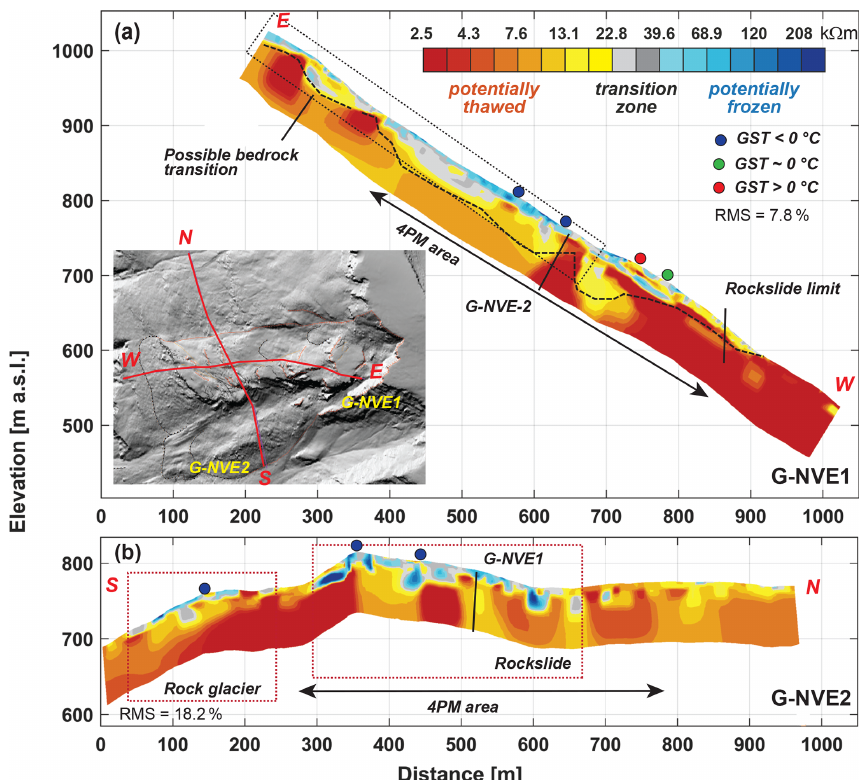
Figure 8. The long ERT profiles for Gámanjunni-3. The colour scale follows the laboratory analysis shown in Fig. 3 and is a logarithmic scale. (a) G-NVE1, showing high-resistivity layers down to ca. 700ma.s.l. (box). The dashed line indicates the possible transition to solid bedrock. (b) G-NVE2, the cross-profile over the rock glacier and the lower rockslide area, indicated by the red boxes. The circles in both profiles indicate the location and mean annual GST in the vicinity of the profiles based on Eriksen (2018) and subsequent measurements (Gudrun D. Majala, NVE, unpublished data, 2020). They show sub-zero temperatures in areas with high-resistivity surface layers and higher values below 700ma.s.l. The part of the profile used for the four-phase model (4PM) is indicated in both profiles (Fig.